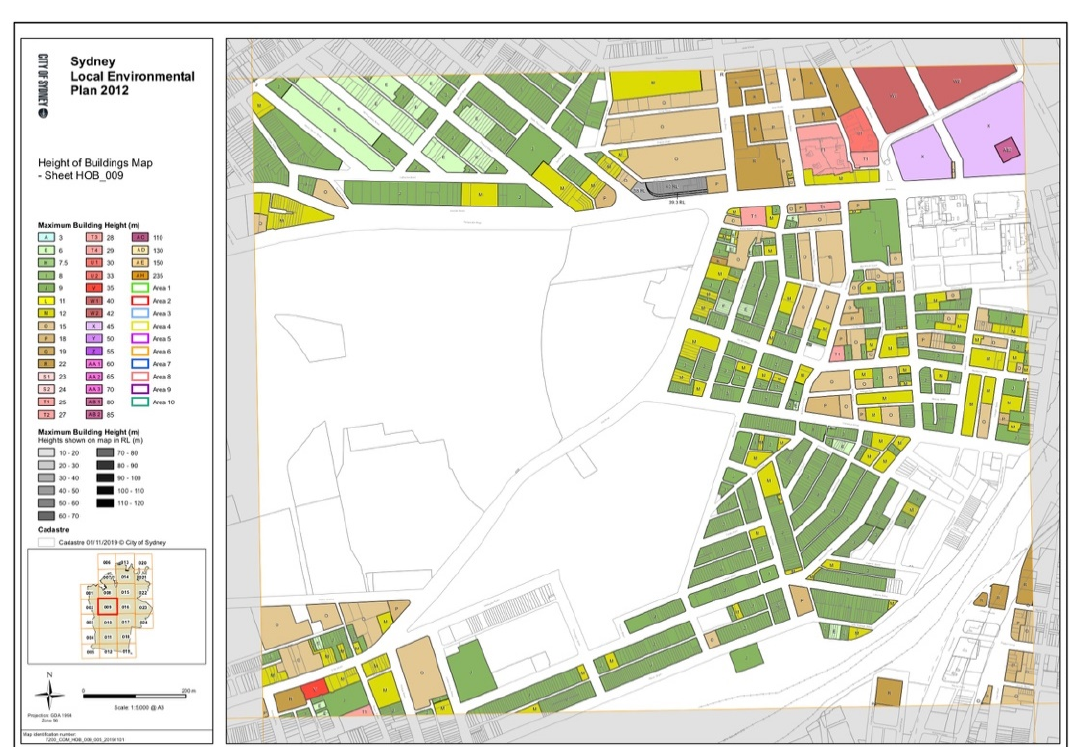
Figure A3. Chippendale Height of Building LEP.